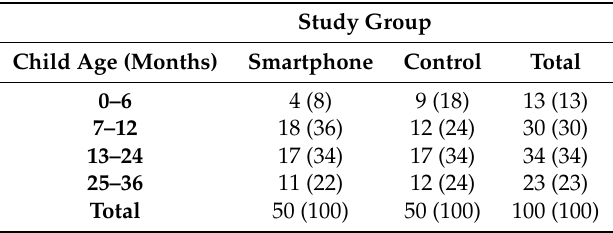
Table 2. Age of participating children ( n